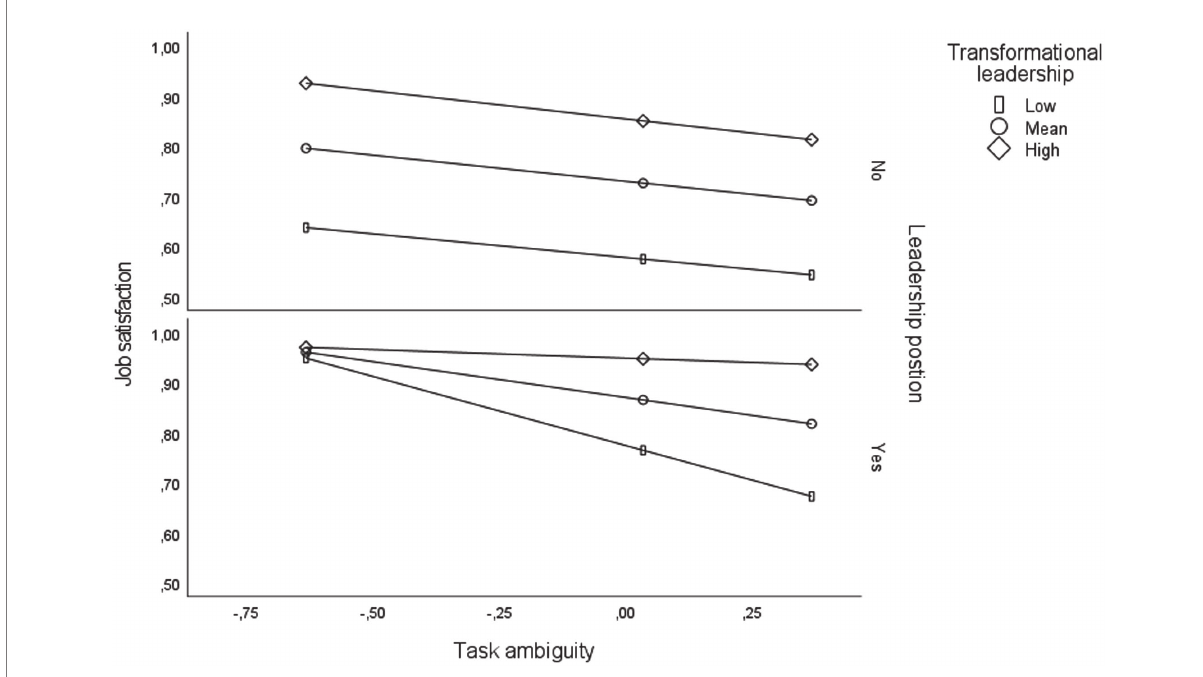
FIGURE 1 Three-way interaction between task ambiguity, transformational leadership, and position as a supervisor regarding job satisfaction adjusted for age and gender (Study